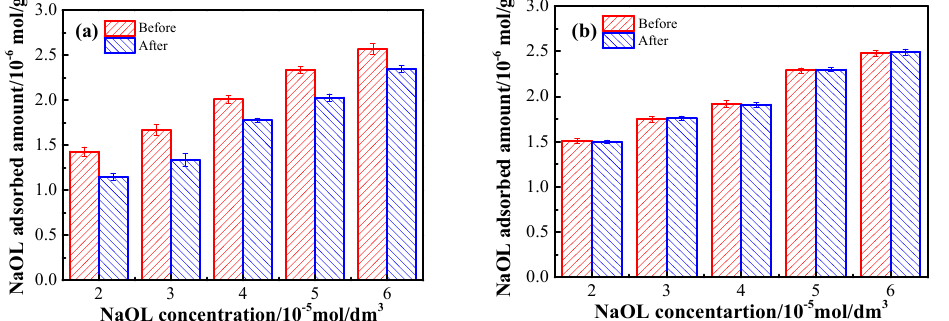
Figure 6. Effect of NaOL concentration on the adsorbed amount of NaOL on minerals surfaces in the absence and presence of Al (III) ions (at pH 8.0): ( a ) cassiterite surfaces; ( b ) clinochlore surfaces.